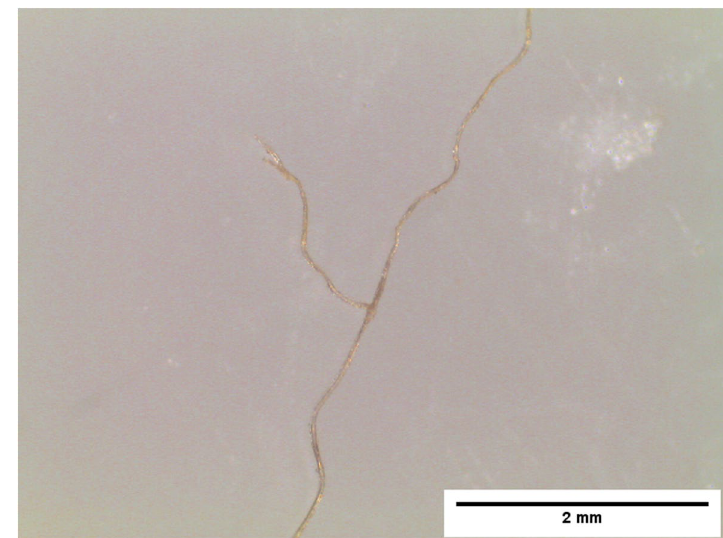
Fig. 1 Light microscope image showing the Y-shape of one fibre from smoked cigarette